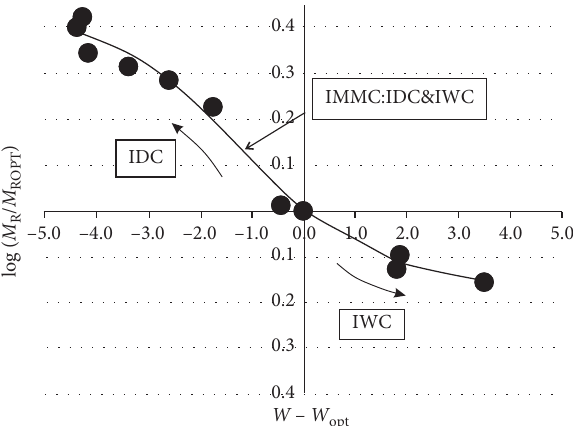
Figure 5: M r -water relationship along the IDC and the IWC (i.e., IMMC) (from